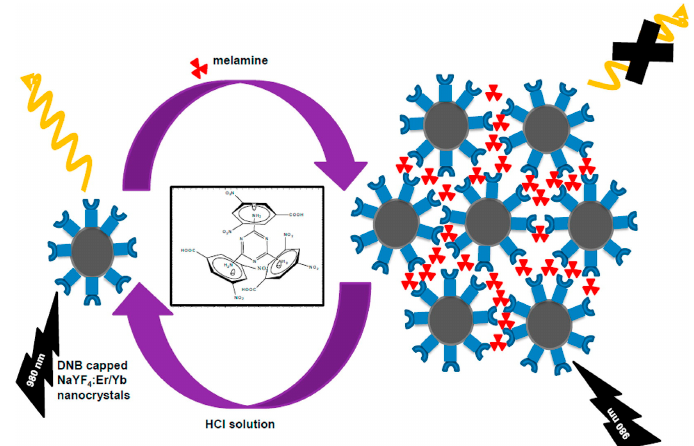
Figure 15. Scheme illustrating the interaction of melamine with 3,5-dinitrobenzoic acid (DNB) -capped NaYF 4 :Er 3+ /Yb 3+ nanocrystals (reproduced with permission from Reference [96]).